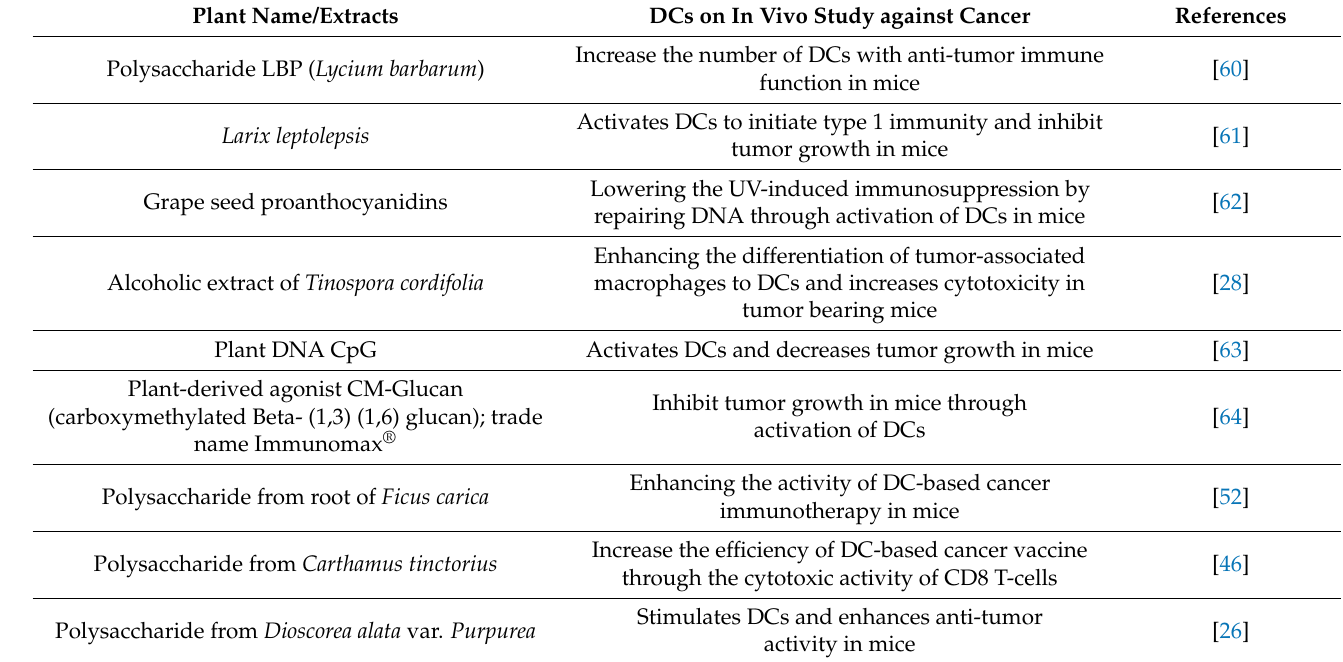
Table 5. Plant extracts pulsed DCs on in vivo study against